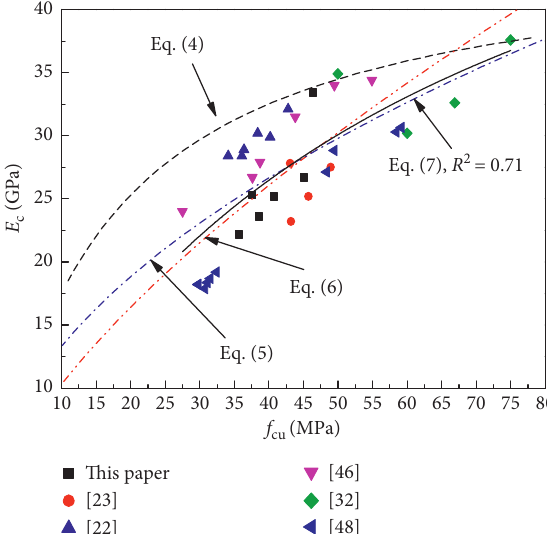
Figure 12: Relationship between E